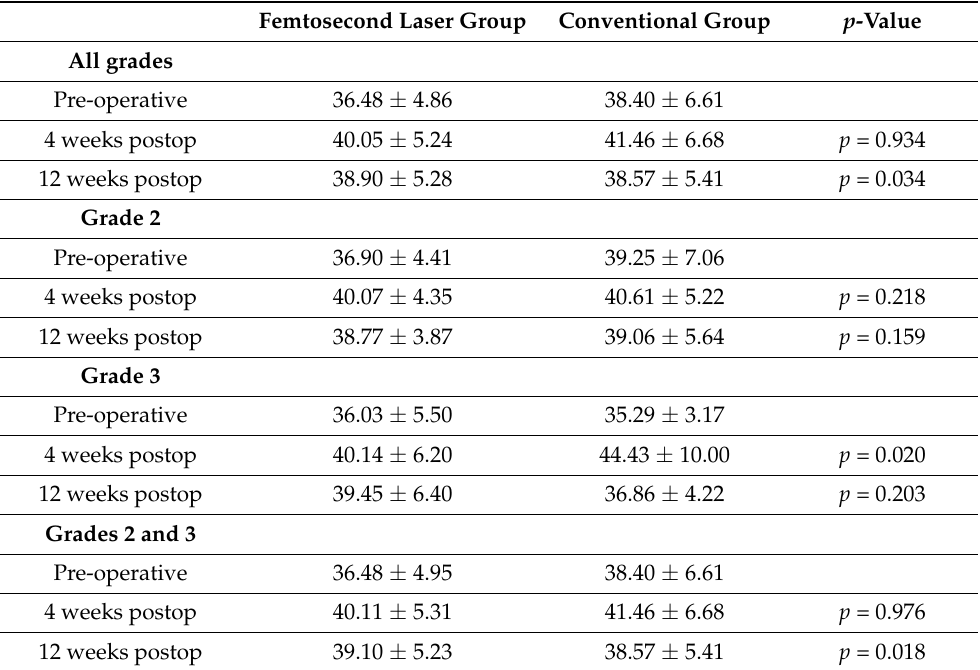
Table 3. Comparison of the coefficient of variation of the endothelial cell area (CV) in % between the femtosecond laser and conventional group over time, for all eyes and split into